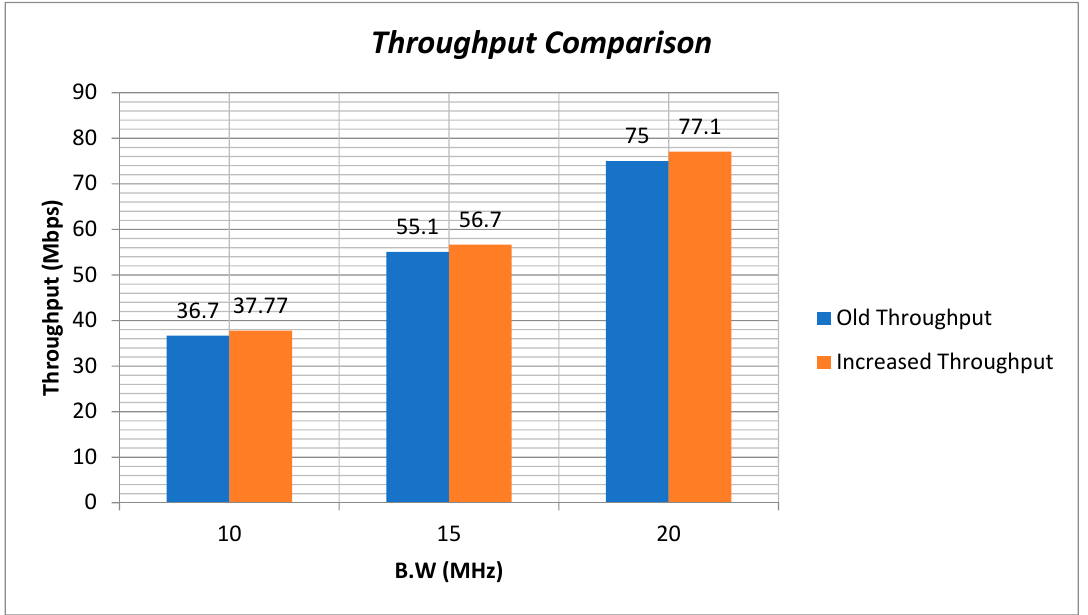
Figure 11. Throughput comparison for 64 QAM.